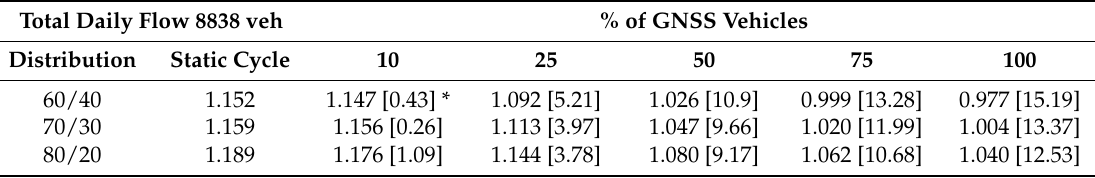
Table 9. Average NO x pollution [g/km], in a typical day, for Case